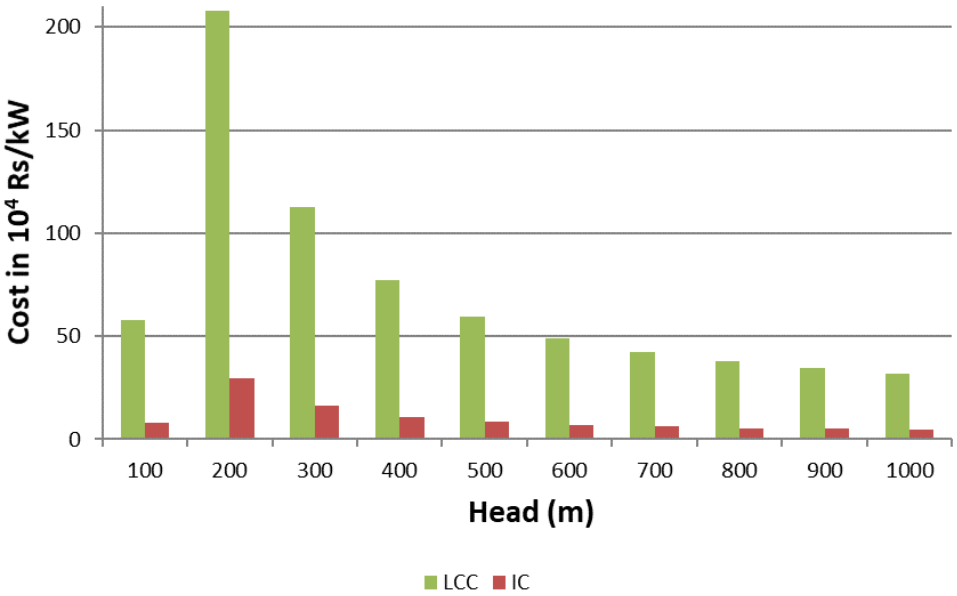
Figure 5. Variation of IC vs. LCC w.r.t head for 2000 kW plant.